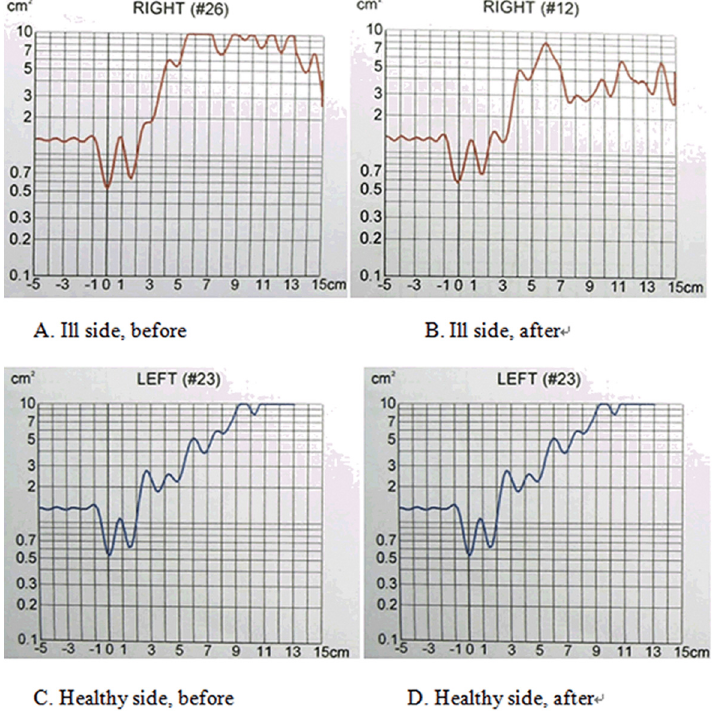
Fig 2. The nasal cross-sectional area versus the distance curves of a patient before and after obturator placement. A-D shows the significant geometrical morphology and volume changes of the cavity after obturator placement on the ill side. The before and after curves of the healthy side are similar, with minimal changes.